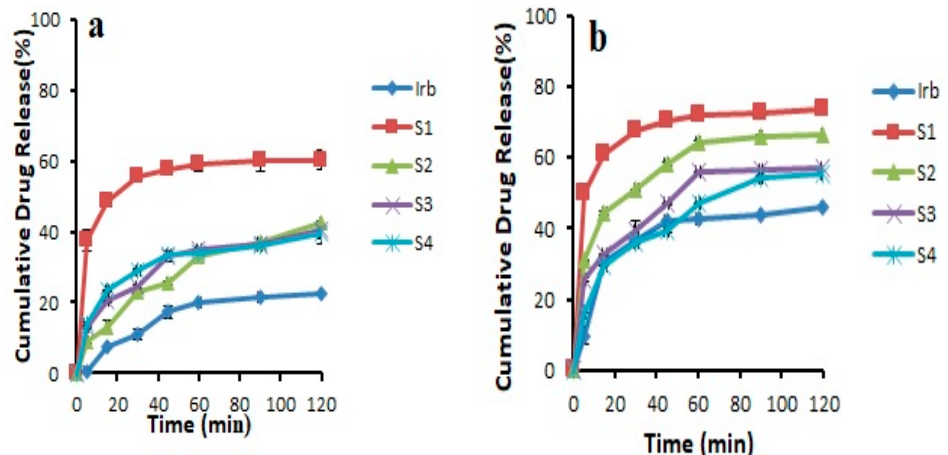
Figure 4. Dissolution profile of binary solid dispersions prepared with Soluplus ® in ( a ) pH 6.8 phosphate buffer ( b ) 0.1 N HCl (n = 3, mean ± SD).